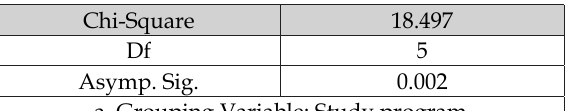
Table 5. Kruskal Wallis Test for perceived knowledge and